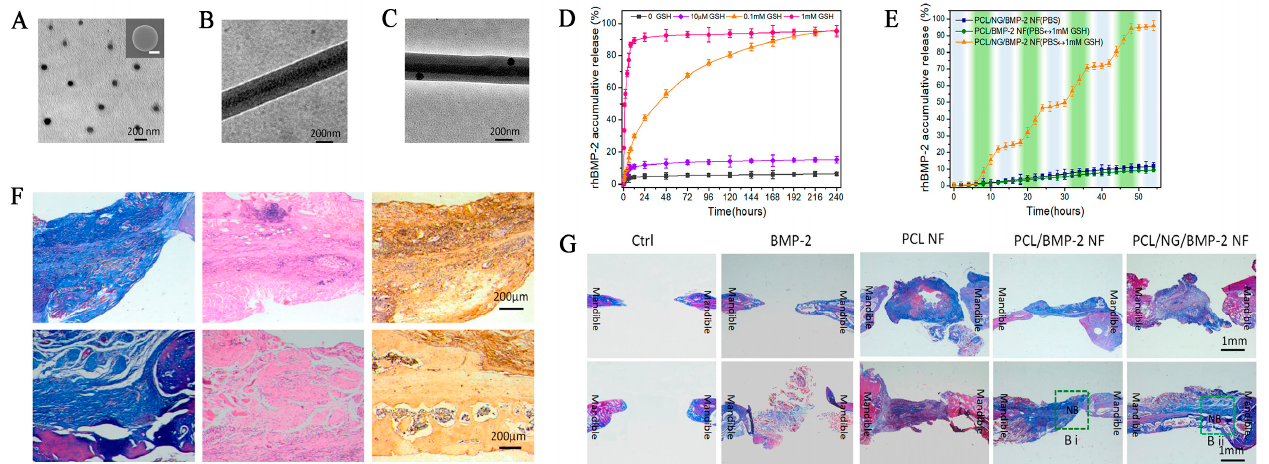
Figure 6. ( A ) TEM and SEM (the inset) images of nanogels ( B , C ); TEM images of nanogel in nanofiber; ( D ) redox-responsive release behavior of BMP-2 in different GSH contents at 37 ◦ C; ( E ) stepwise response of nanofibers on increasing GSH concentration; ( F ) high magnification of Masson, HE, and immunohistochemical staining of the bone defect; ( G ) histomorphometric results of the bone defect area (NB: new bone). Reprinted with permission from